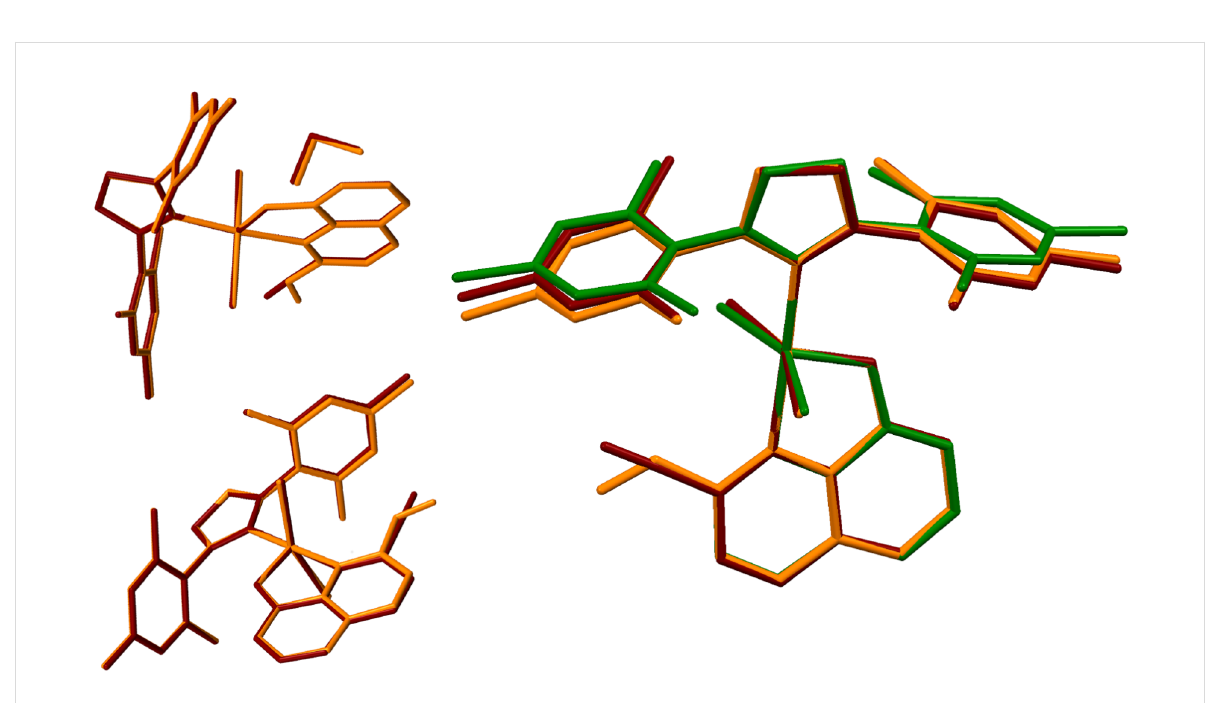
Figure 3: Superposition of the asymmetric parts of units’ cells in both investigated structures: an example of isostructural packing (left). Superposition (right side) trans forms of all studied molecules 5a (green), 14 (ruby) and 15 (orange).